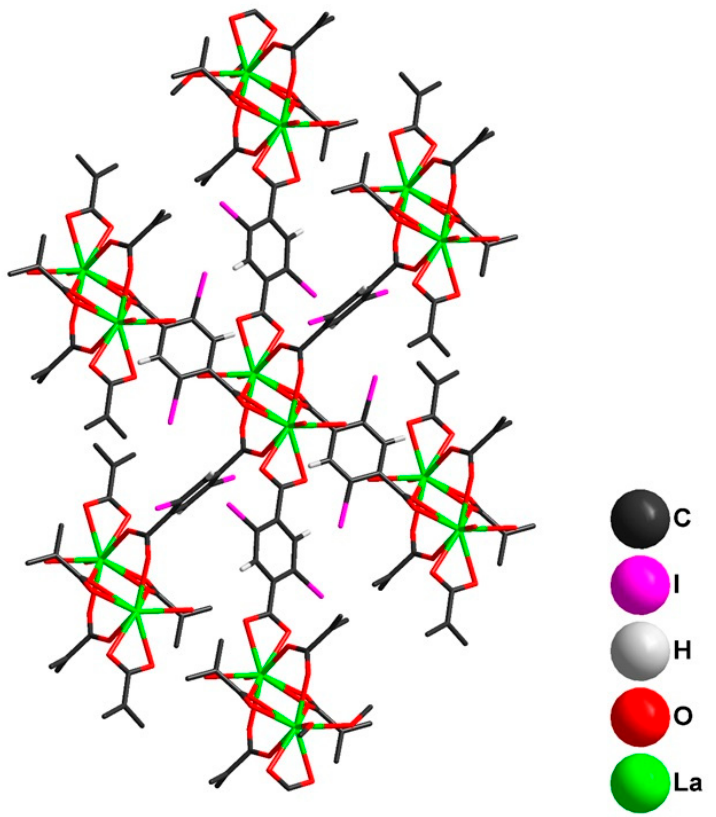
Figure 6. Connectivity between [La 2 (2,5-I-bdc) 6 (DMF) 4 ] units in the crystal structure of 2 .